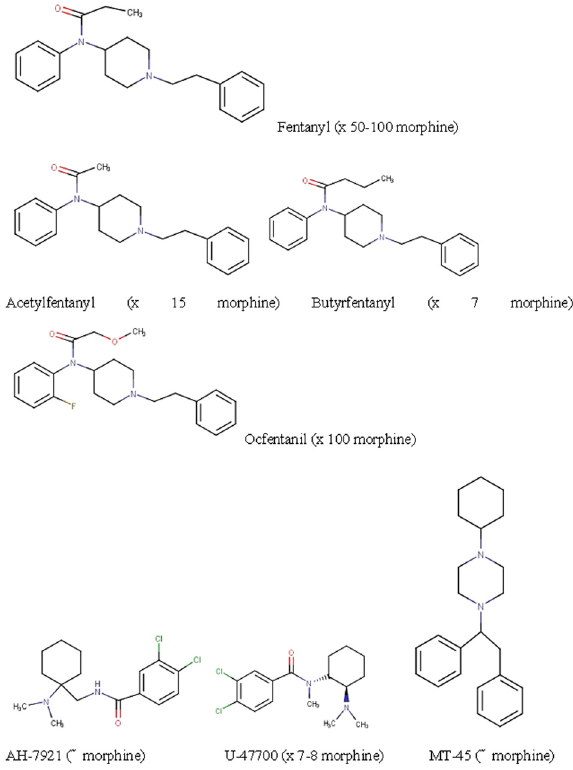
Figure 6: Structures and potencies of NSOs [ 428